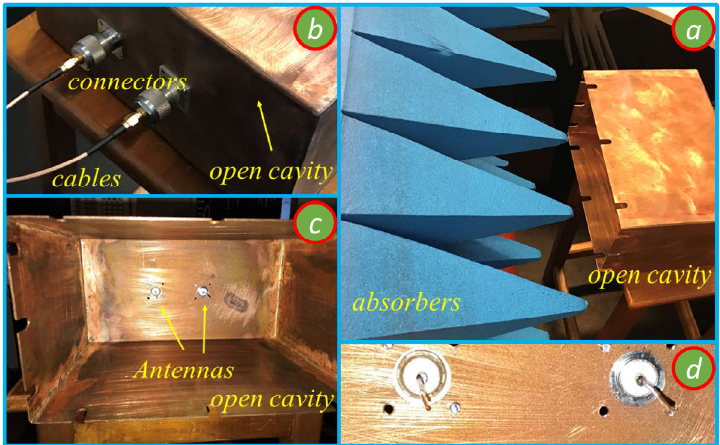
Figure 2. Gaussian pulse with a bandwidth of 0 to 10 GHz that was used.